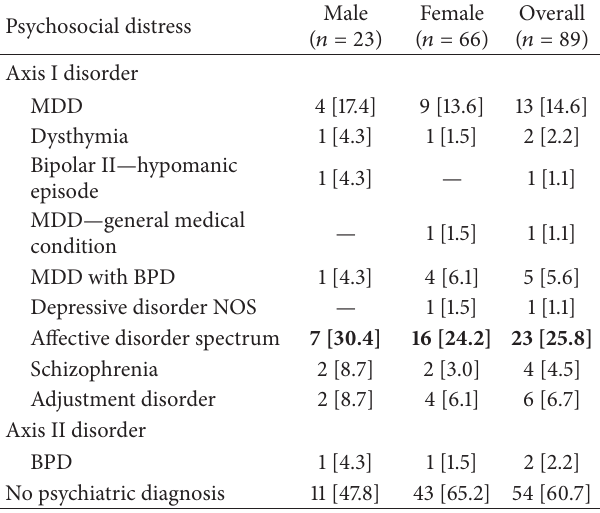
Table 4: Diagnostic distribution of the cases.